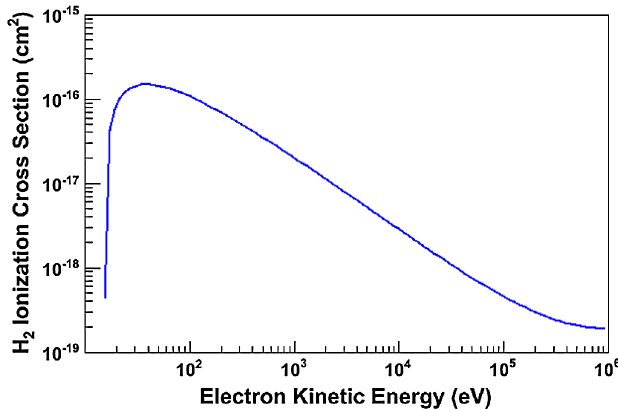
FIG. 2. Electron impact ionization cross section for H 2 [21], the dominant gas species inside a modern baked ultrahigh vacuum (UHV) dc high voltage photogun, as a function of electron kinetic energy. photocathode energy band structure. Impinging ions might also sputter away the chemicals used to reduce the work function at the surface of the photocathode. Predicting